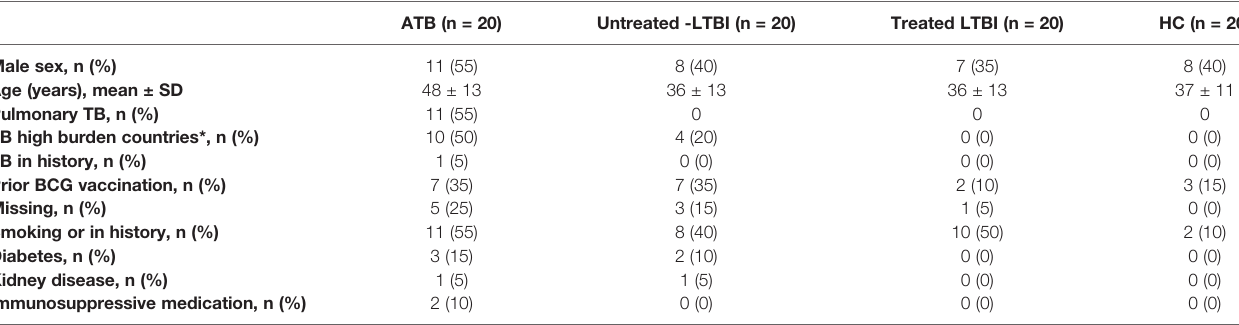
TABLE 1 | Baseline characteristics of the discovery